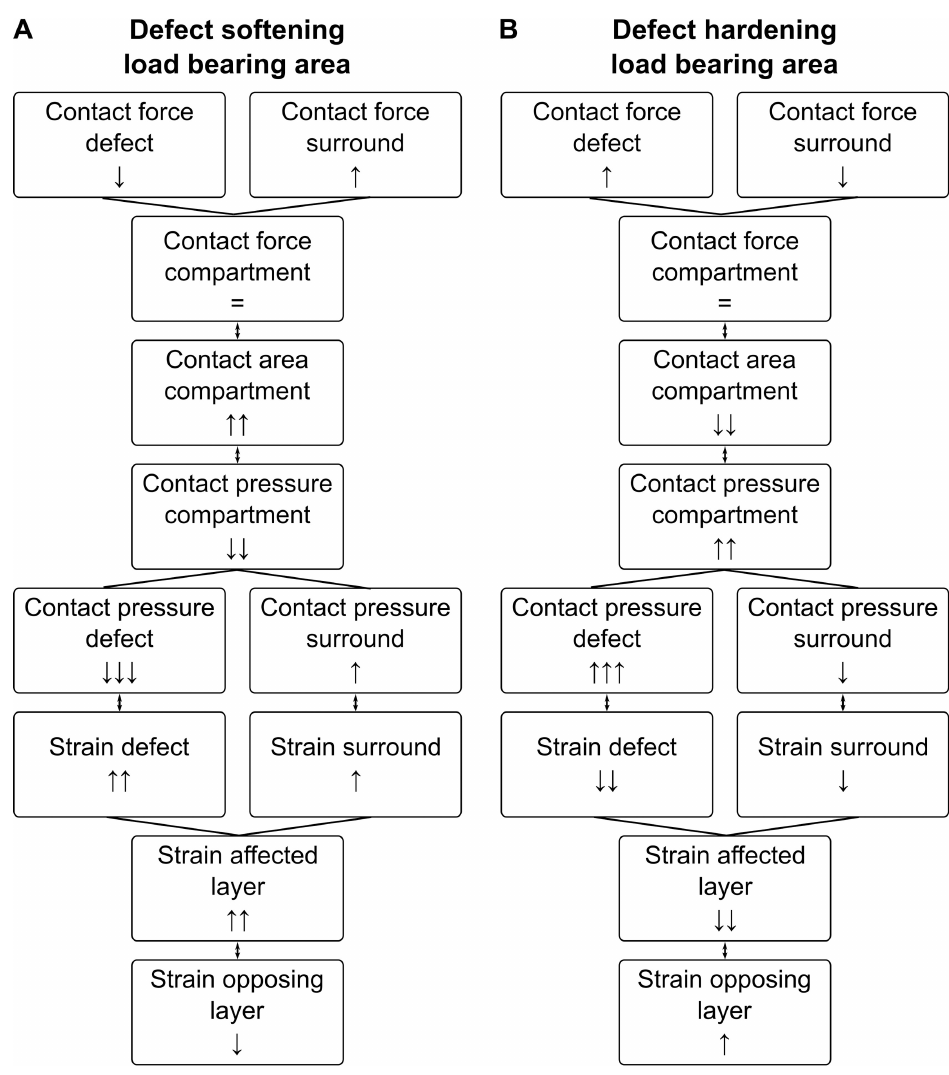
Fig 8. Effect of softening and hardening of a cartilage defect in the load bearing